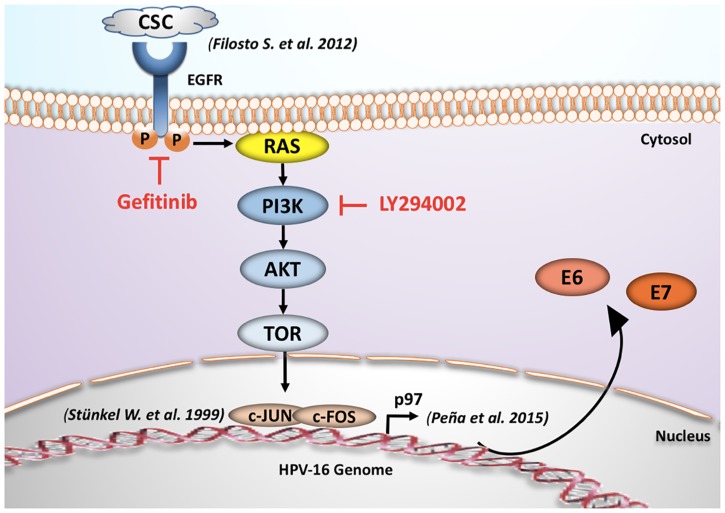
Proposed mechanism for tobacco smoking-mediated E6/E7 overexpression. The acute exposure to cigarette smoke condensate increases the transcription of early HPV16 E6 and E7 genes through EGFR/PI3K/Akt/AP-1 signaling pathway and subsequent p97 promoter activation in CaSki cells (Stünkel and Bernard, 1999; Filosto et al., 2012).